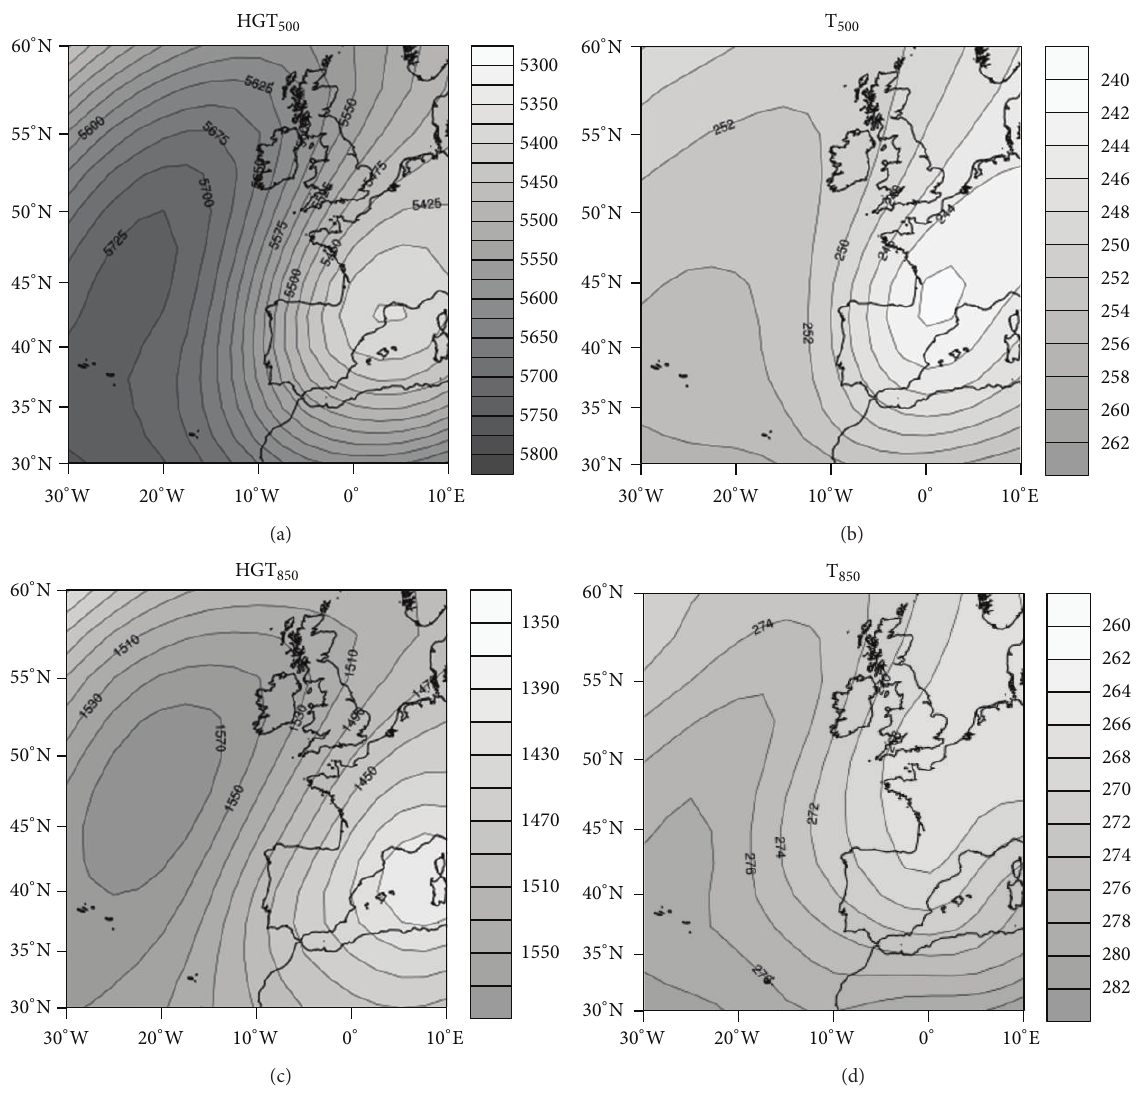
Figure 7: As in Figure 2 but for cluster